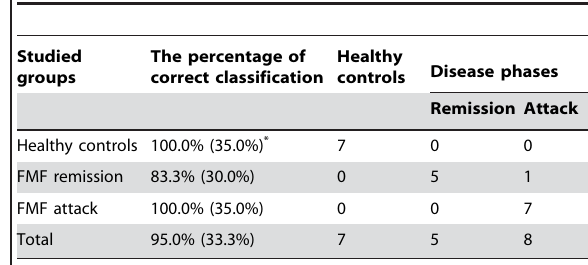
Table 8. Classification table of correct estimates based on FISH variables.